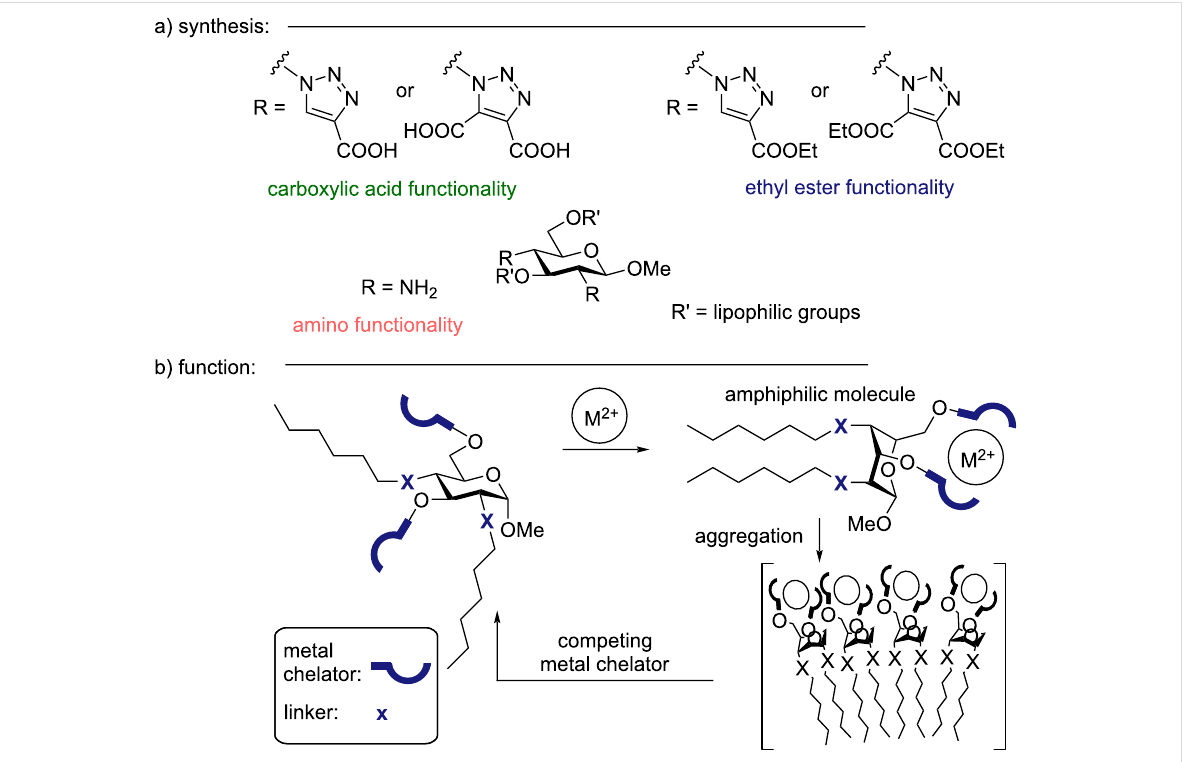
Figure 1: a) The carbohydrate-based building block for the synthesis of stimuli-responsive surfactants. b) The concept of stimuli-responsive surfac-